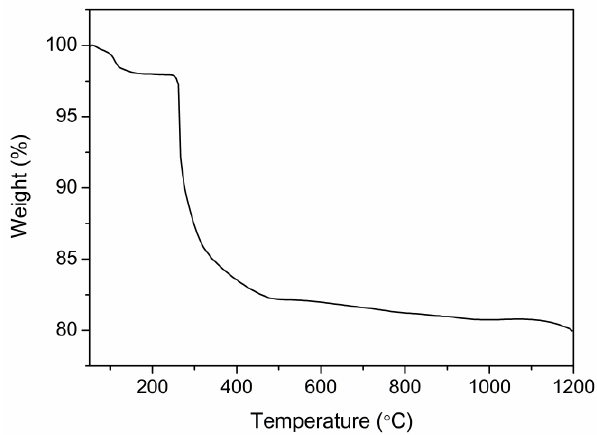
Figure 3. TGA results of the copolymer P(ND- co -D) from 50 °C to 1200 °C.